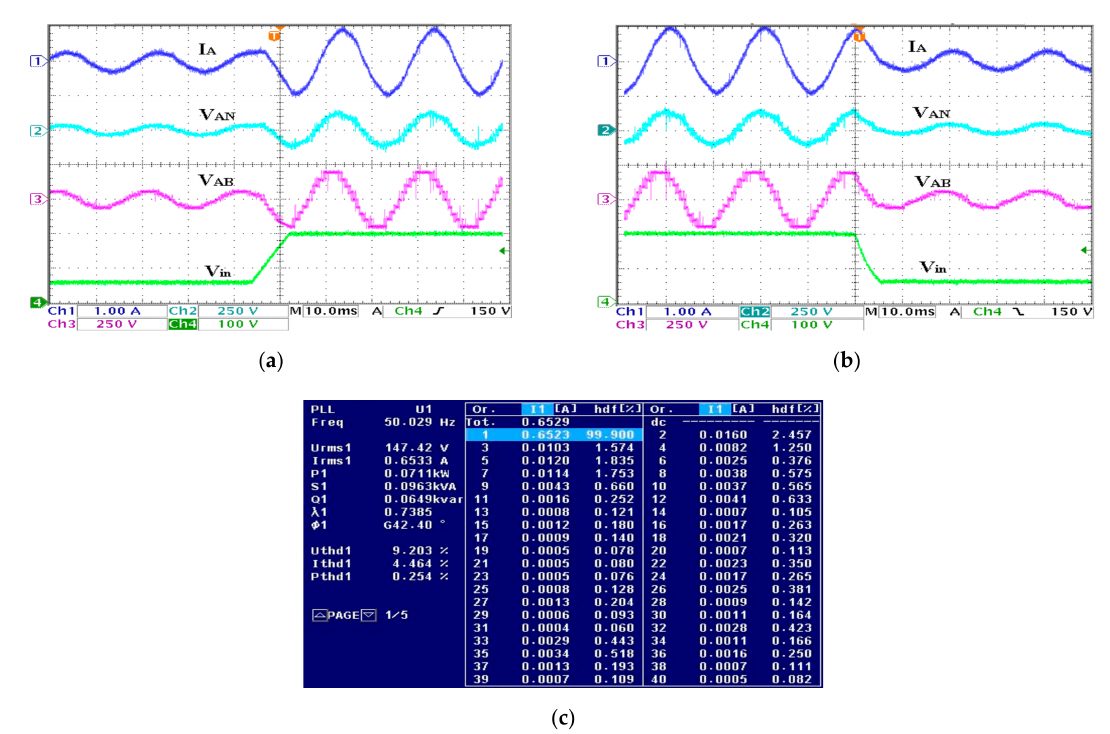
Figure 14. Experimental results of inverter’s waveforms (output current I A, phase voltage V AN , line-to-line voltage V AB and input voltage V in ) with online tuning for a step response with V in changes between 60 V and 200 V. ( a ) Step-up response, ( b ) step-down response, ( c ) output current harmonics.